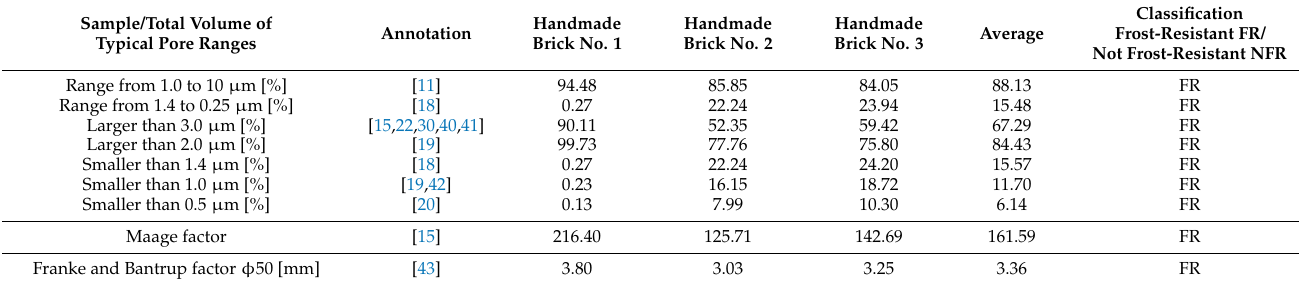
Table 9. Hand-made brick frost resistance prediction